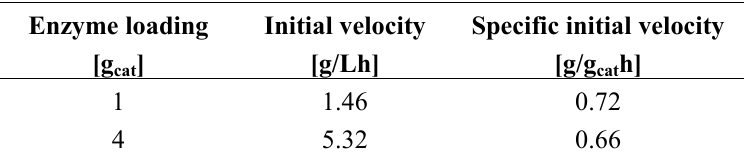
Table 1 . Enzyme performance at different loadings.